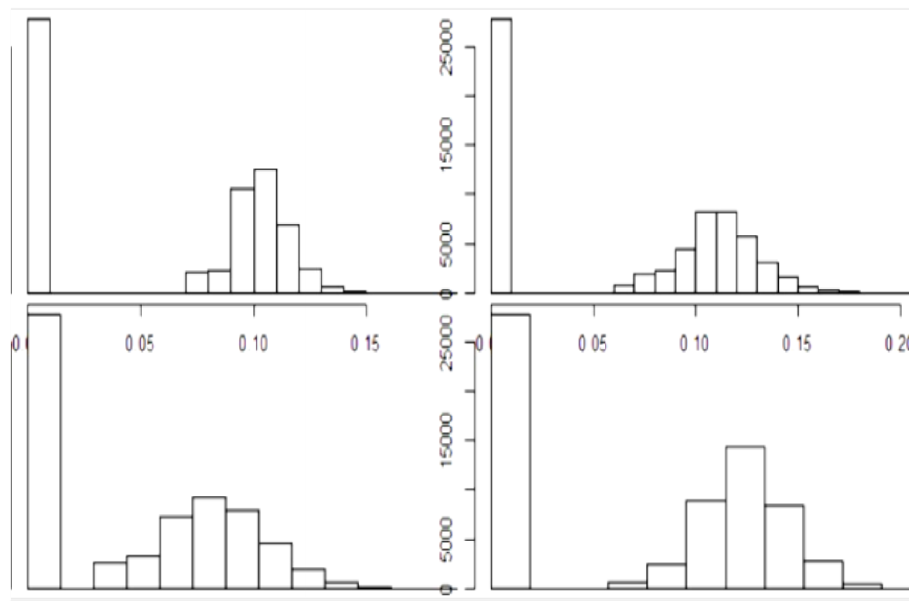
Figure 4. The Statistical distribution of training